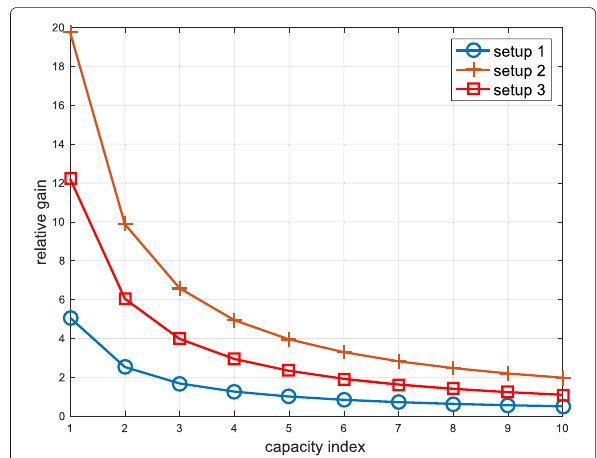
Fig. 6 Relative performance loss of hard constraint versus the index of I n ,max in Markov